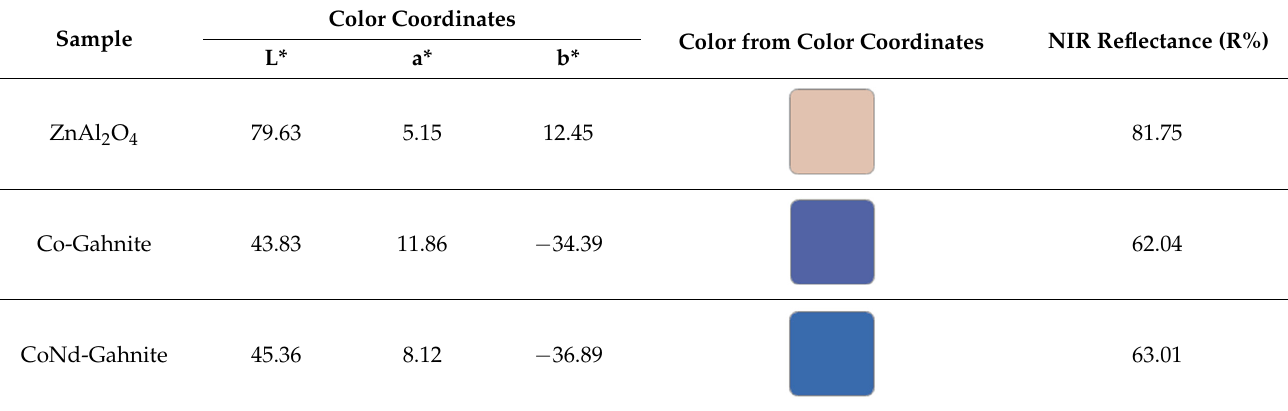
Table 1. Color coordinates, NIR reflectance of the powdered pigments.